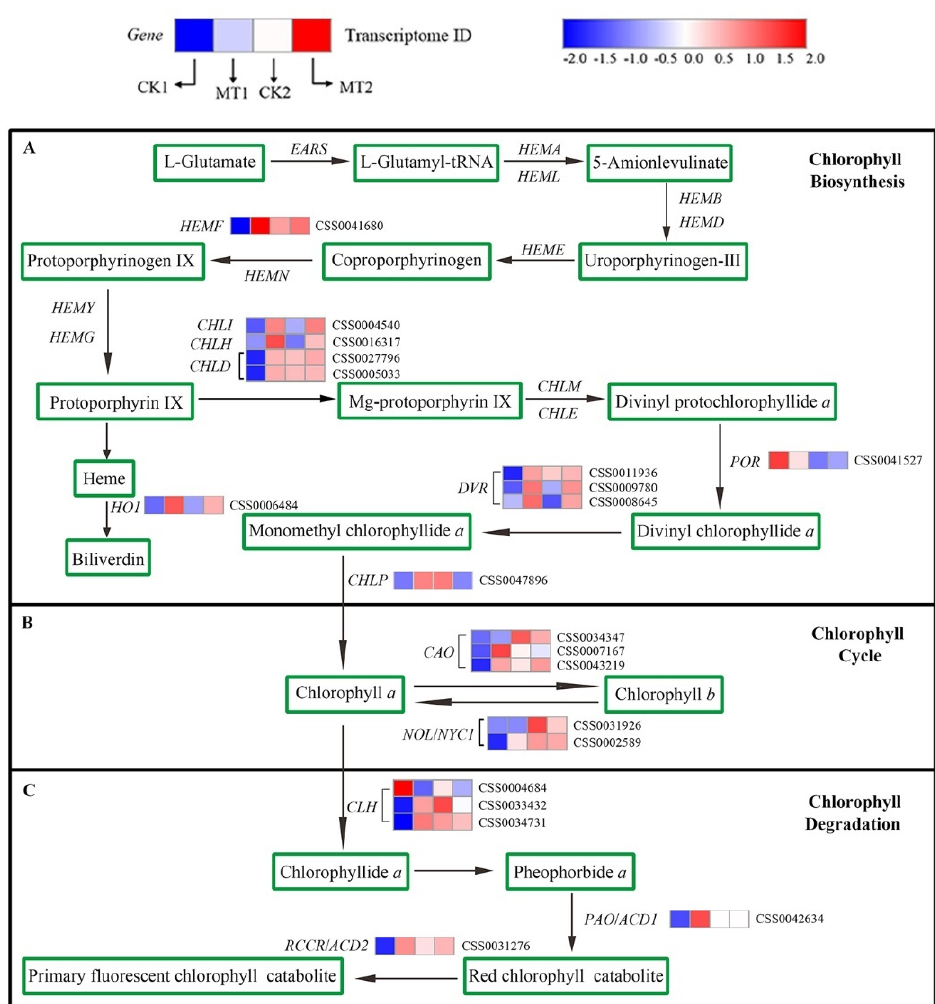
Figure 7. Chl metabolic pathway and heatmap of expression levels of Chl metabolism related genes identified in DEGs. ( A ) Chlorophyll Biosynthesis; ( B ) Chlorophyll Cycle; ( C ) Chlorophyll Degradation. Blue and red represent low and high expression, respectively. The different vertical columns represent different treatments, from left to right: CK1, MT1, CK2, and MT2.